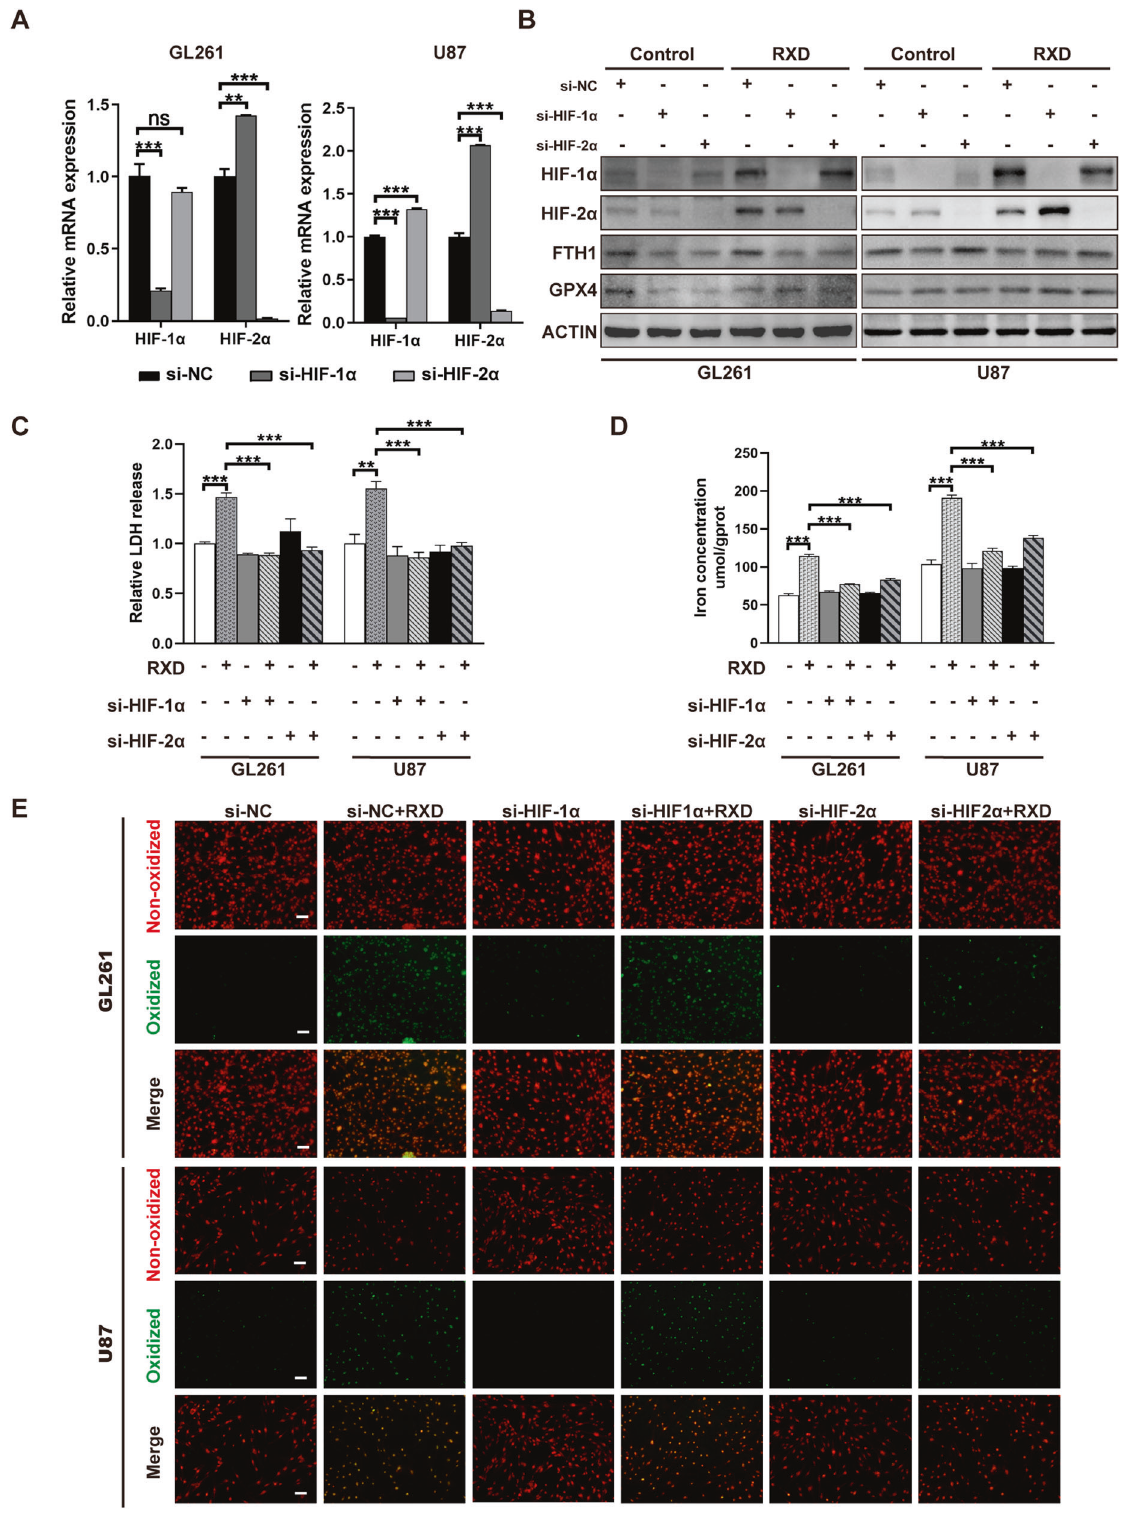
Fig. 7 HIF- α activation mediated roxadustat-induced ferroptosis in chemoresistant GBM cells. A Histogram of mRNA expression of HIF-1 α and HIF-2 α in GL261 and U87 cells transfected with HIF-1 α , HIF-2 α and scrambled siRNAs for 48 h. B Western blotting analysis of protein expression in GL261 and U87 cells transfected with siRNAs for 48 h and with/without RXD treatment (100 μ M towards U87, 200 μ M towards GL261) for 48 h. C LDH release in GL261 or U87 cells transfected with siRNA for 48 h and treated with/without RXD for 72 h. D Cellular iron concentration of GL261 or U87 cells transfected with siRNA and treated with/without RXD for 48 h. E Representative fl uorescent images of lipid peroxidation in GL261 or U87 cells in each group. Scale bar: 100 μ m. * P < 0.05, * *P < 0.01, *** P < 0.001.